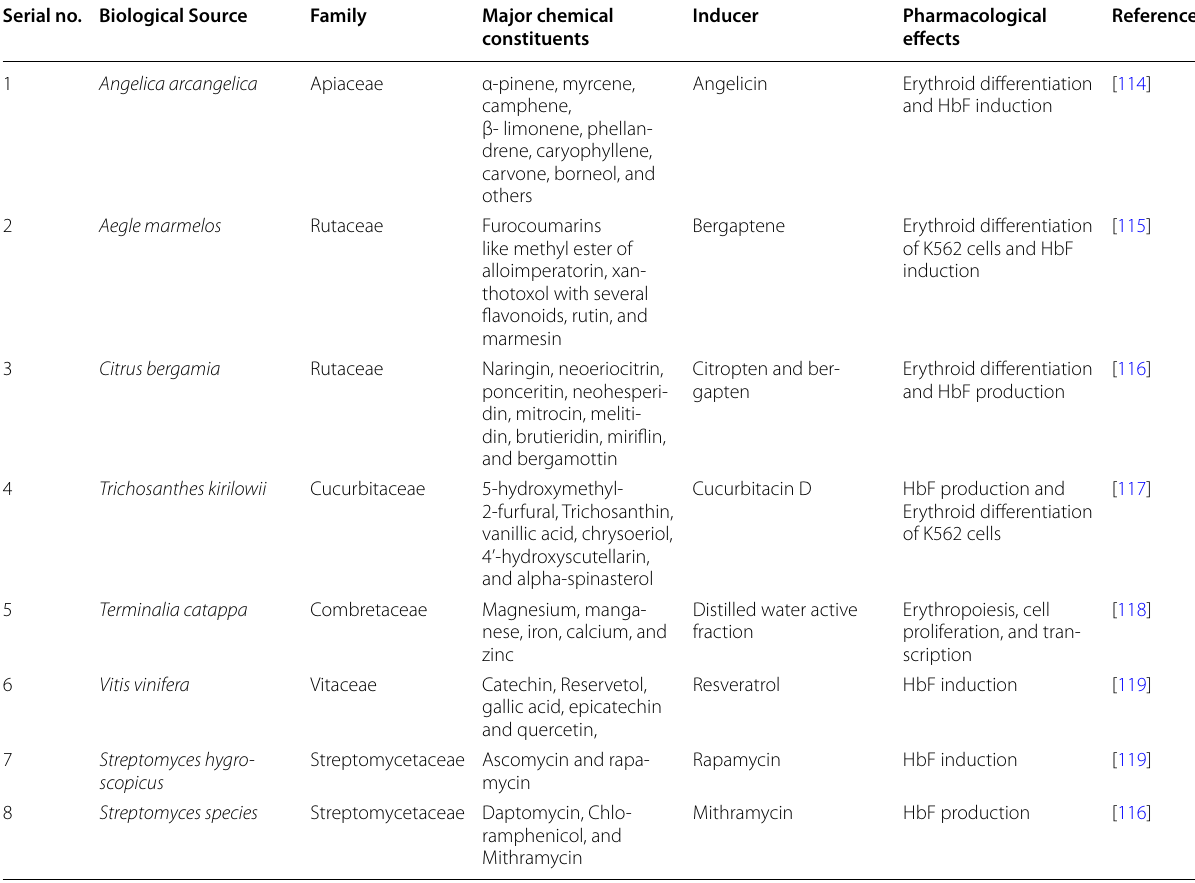
Table 2 Natural therapies associated with sickle cell disease Serial no. Biological